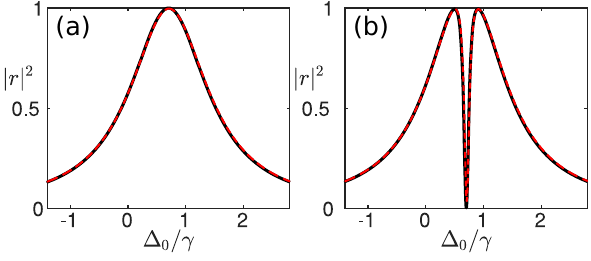
Figure 2: Accuracy of the two-mode model. Reflectance from a 30 × 30 lattice calculated from two-mode model (full black line) and full numerics (dashed red line) for (a) δ (cid:1) 0 where P I is excited on resonance at Δ 0 = 0.71 γ leading to total re fl ection and (b) δ (cid:1) 0 . 2 γ where P P is excited, leading to full transmission, with d = 0.54 λ , ˜ δ (cid:1) 0, for Gaussian input with 1 / e 2 radius w = 12 d . Two-mode model uses parameters δ P , I = − 0.71, υ P = 0.003, υ I = 0.83 extracted from numerical